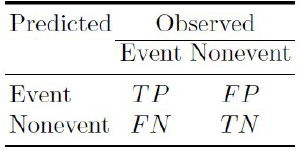
Figure 2. Confusion matrix